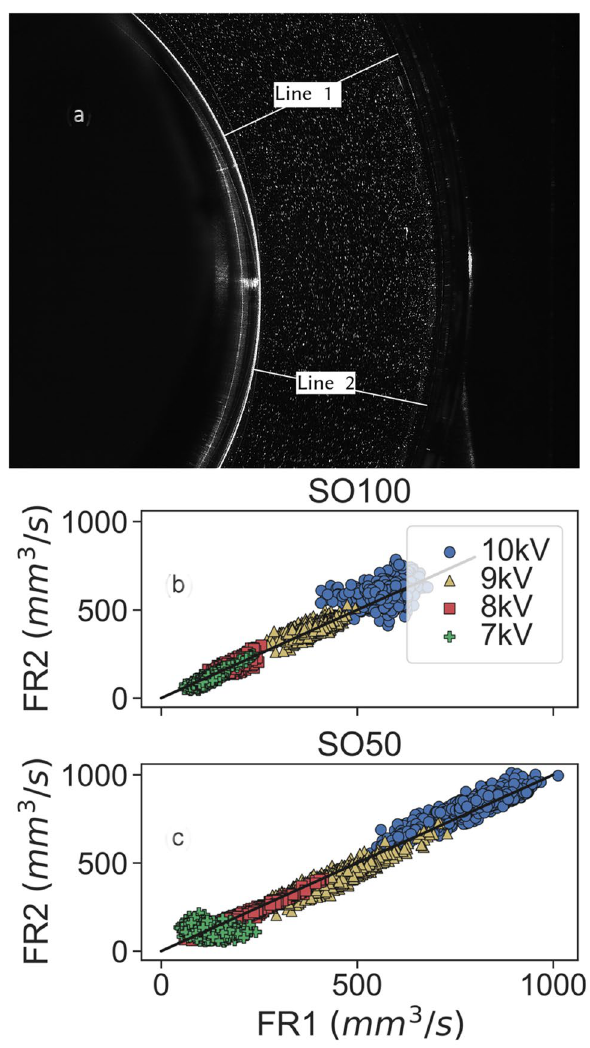
Fig. 4 a Top view of the circular pumping channel with two lines (line 1 and line 2) arbitrarily chosen at different downstream loca- tions. b, c Plots of flow rates at line 2 (FR2) vs. line 1 (FR1) for SO100 and SO50 silicone oils under various corona voltages, respectively. The FR2 = FR1 line is indicative of the mass conservation, and the accuracy of the PIV measurements in the absence of any slosh- ing (out-of-plane)